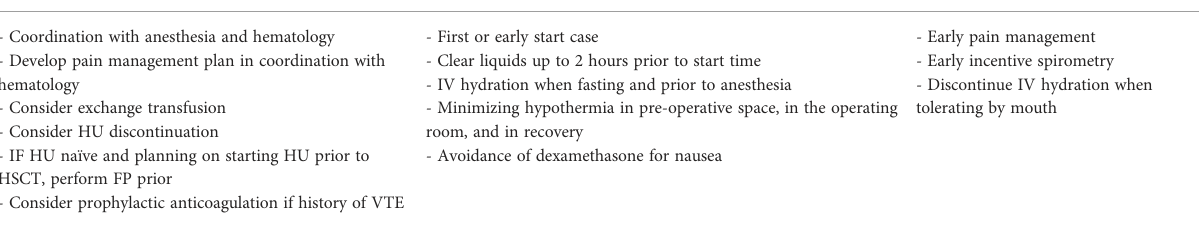
TABLE 6 Perioperative